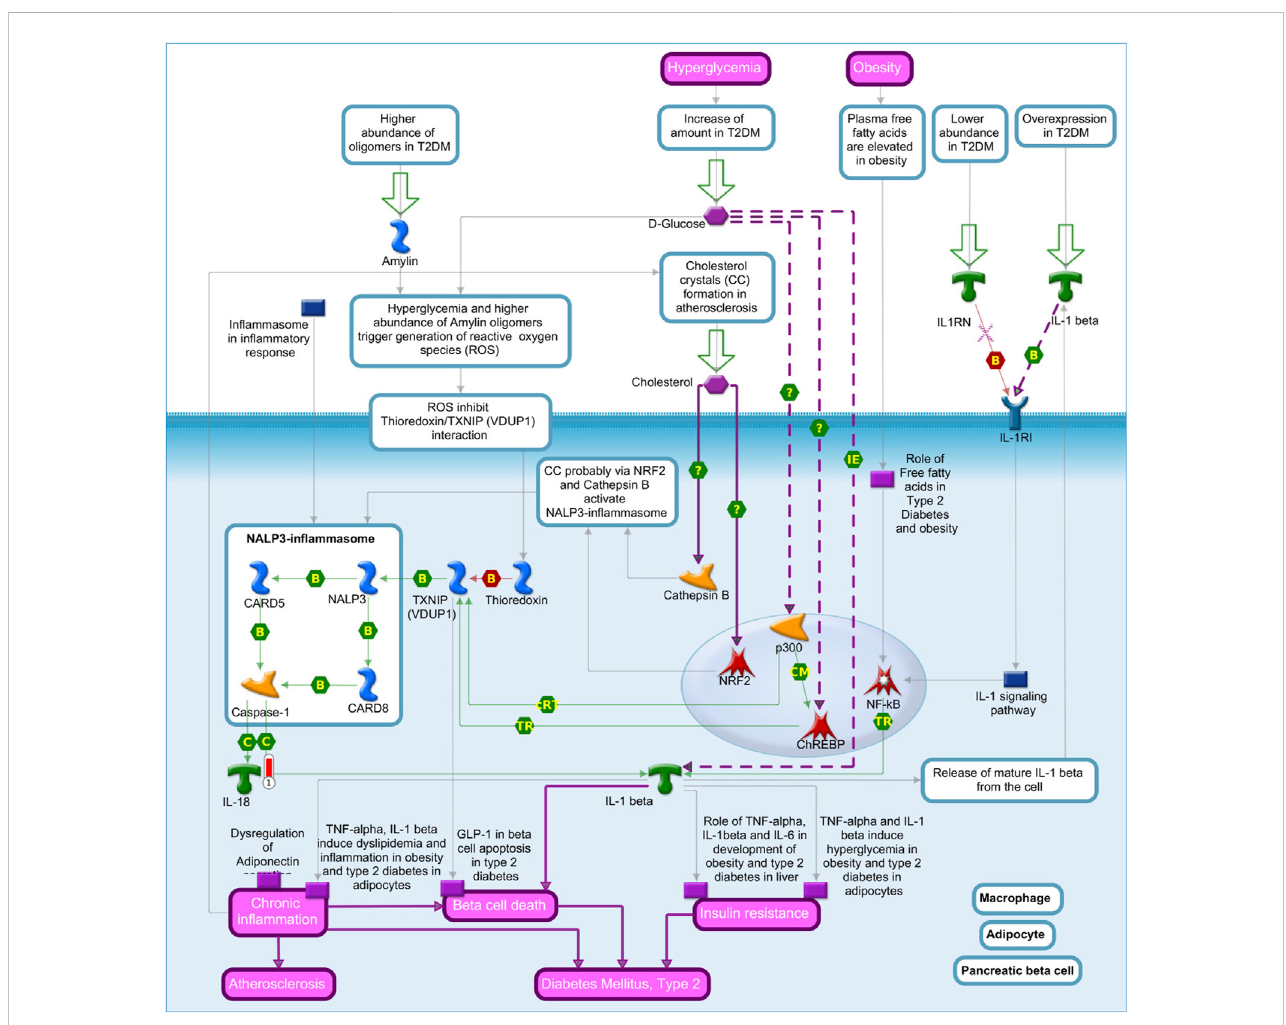
FIGURE 6 Role of the in fl ammasome in macrophages, adipocytes, and pancreatic beta cells in the type 2 diabetes pathway map based on MetaCore software ( p -value < 0.10)fromthelistofdifferentiallyexpressedgenes(FDR10%)inthelivertissueofpigsfedwithdifferentoilsinthediet(3.0%soybeanoiland3.0% fi sh oil). The blue thermometer indicates that the DEG is downregulated in the diet with 3.0% soybean oil (SOY). The large green arrows indicate the path to start. Green arrows indicate positive interactions, and gray arrows indicate unspeci fi ed interactions. Links in purple indicate emerging and enhanced (dotted) diseases.